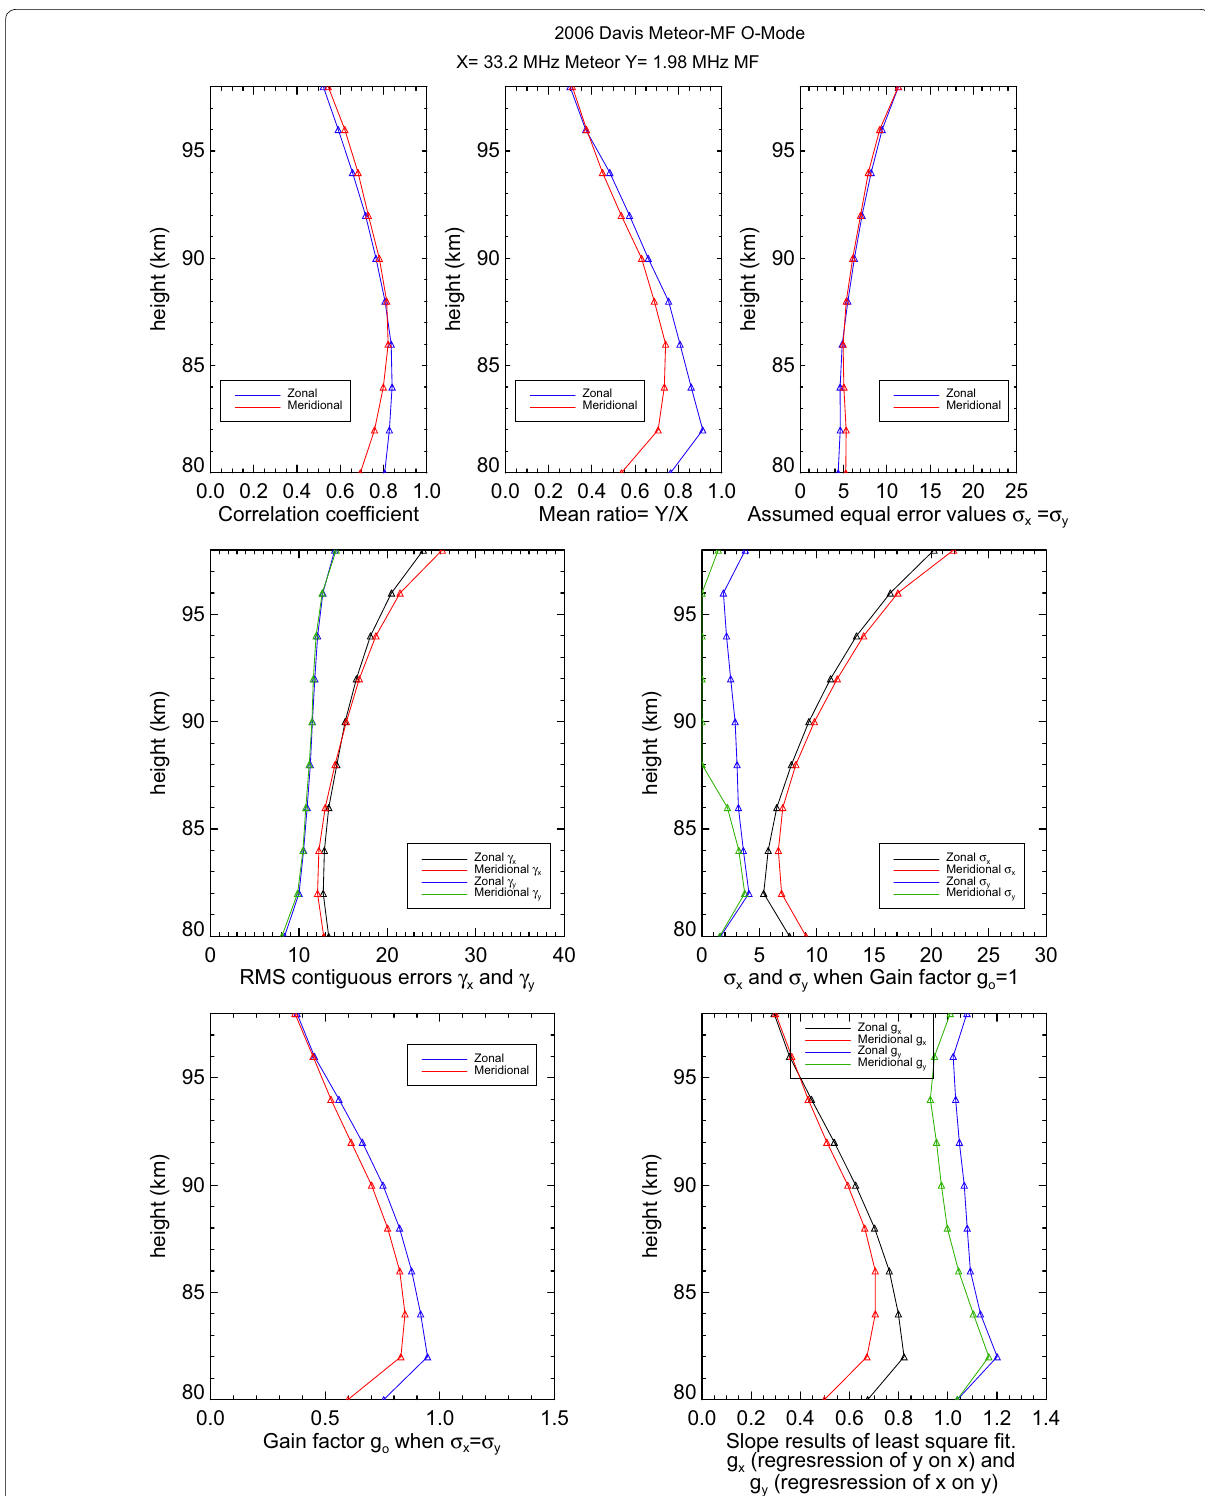
Fig. 6 Davis MF O-mode and 33.2 MHz meteor scatter plot comparison results. The plots above summarize the results from applying the regression analysis to the data at all heights. In the fourth, fifth, and last panels, red and black indicate the 33.2 MHz radar and green and blue the 1.94 MHz radar results. Note that the results at 80 km are of a somewhat different